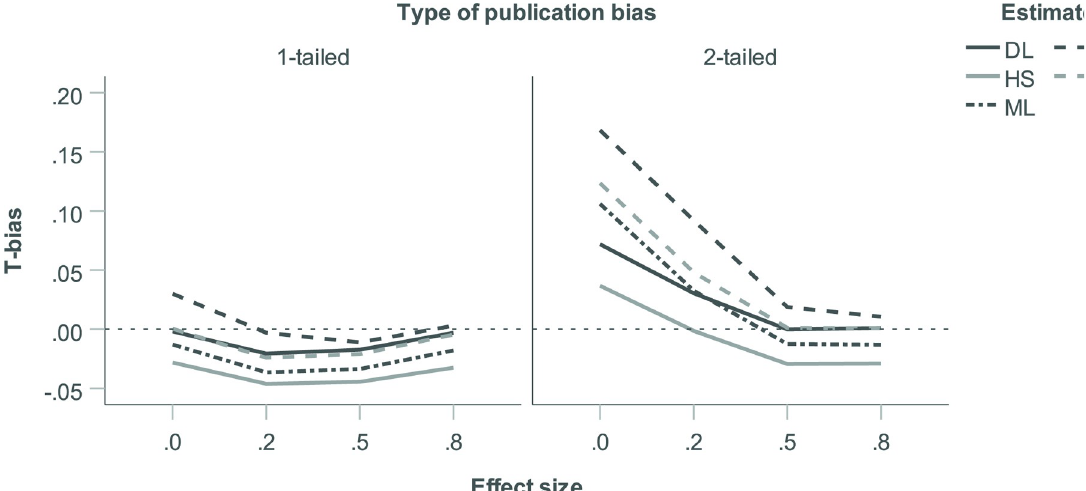
Fig 5. Bias in heterogeneity estimates ( T bias ) for five heterogeneity estimators: Two-way interaction of true average effect size ( θ ) with type of publication bias.